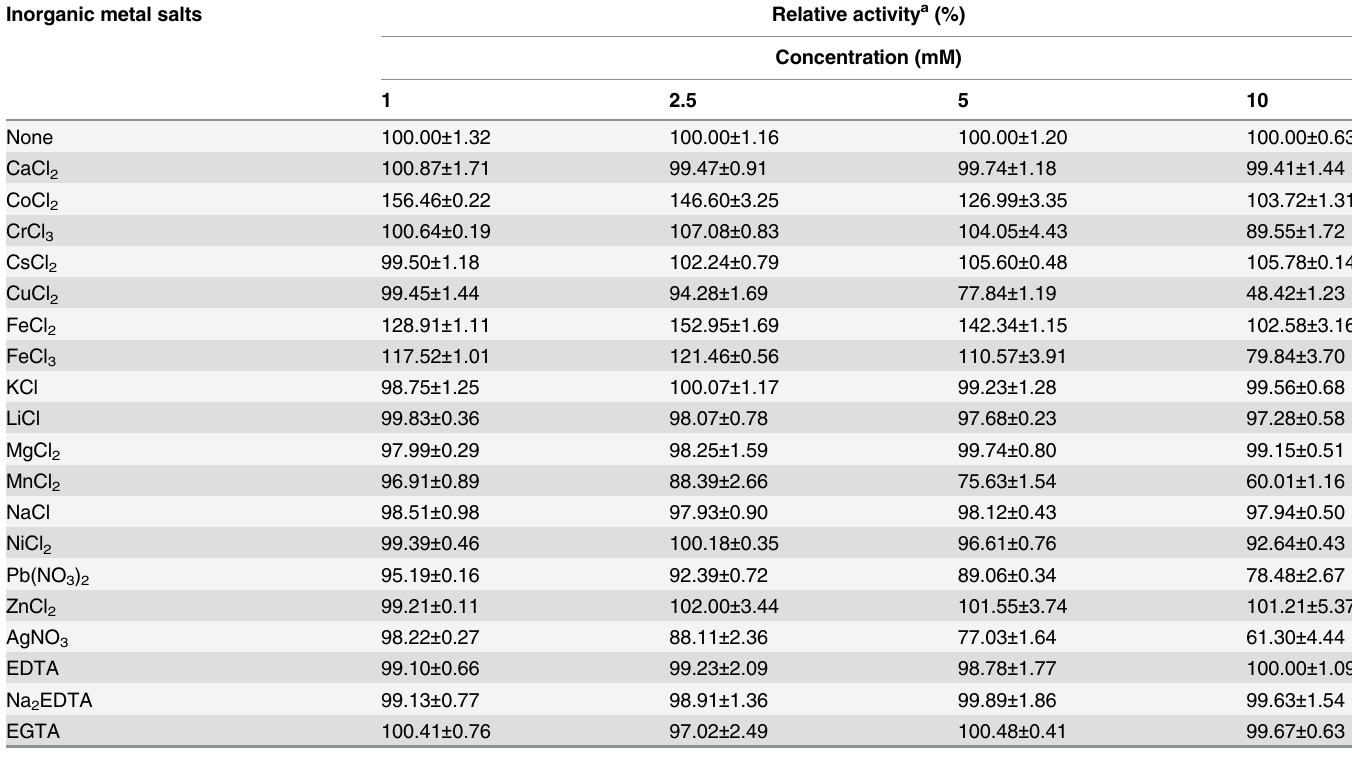
Table 3. Effects of metal ions on the enzyme activity of TpAA. Inorganic metal